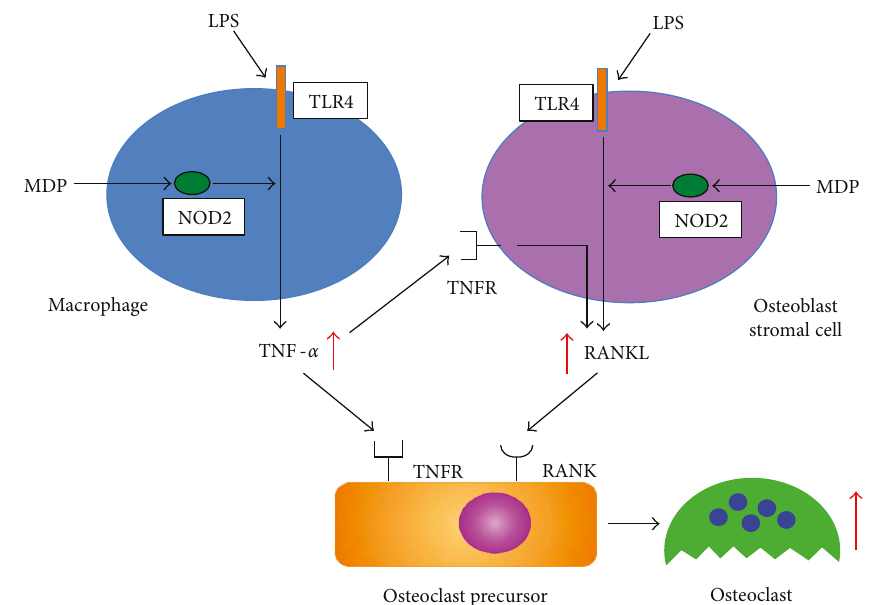
Figure 2: Schematic of the role of MDP in LPS-induced osteoclast formation. LPS induces TNF- α expression; MDP further enhances this TNF- α expression. MDP-enhanced, LPS-induced TNF- α may lead to an increase in RANKL expression by stromal cells. Furthermore, LPS also acts to induce RANKL expression; MDP further enhances this RANKL expression in stromal cells. The MDP-enhanced, LPS- induced TNF- α production synergistically interacts with MDP-enhanced, LPS-induced RANKL, thereby leading to increased induction of osteoclastogenesis. Therefore, the role of MDP in LPS-induced osteoclast formation in vivo may be to strongly promote the induction of this